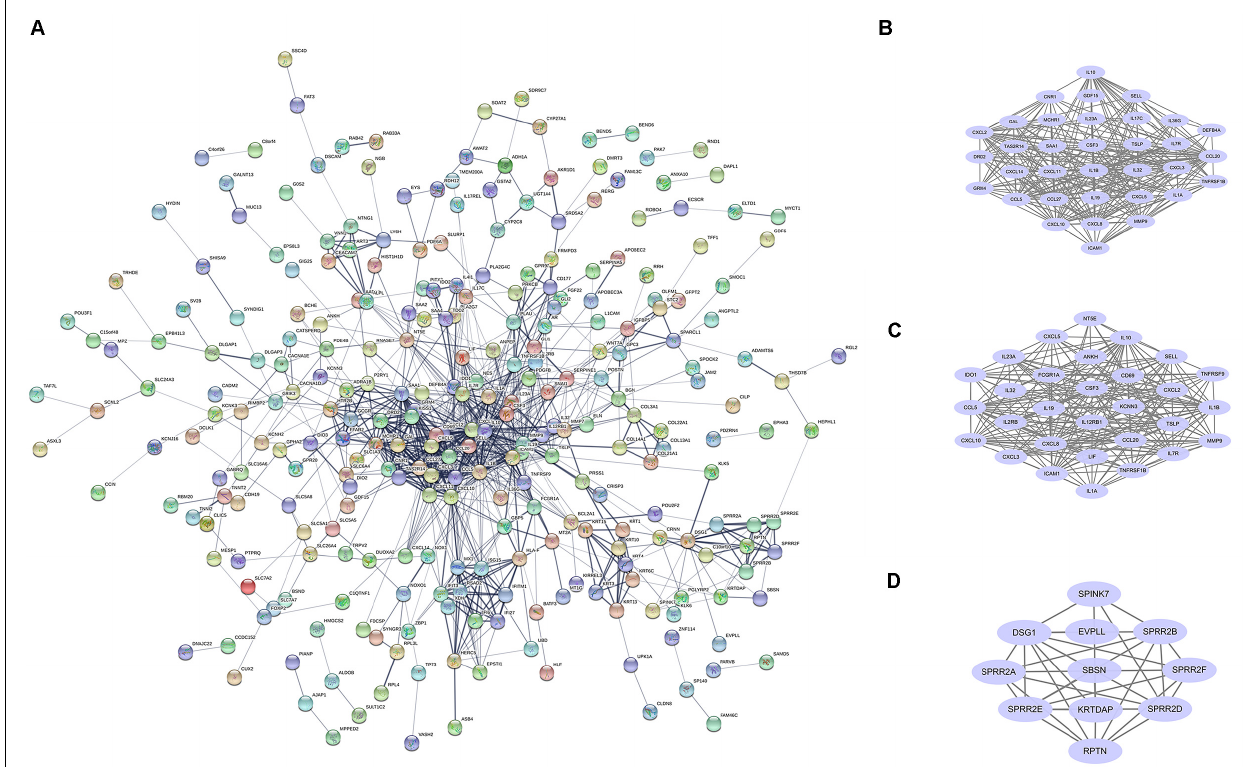
FIGURE 2 | PPI network and core modules analysis of DEGs in GSE150819. (A) The PPI network of DEGs was constructed by STRING. (B–D) ClusterONE identified the core modules in the PPI network.